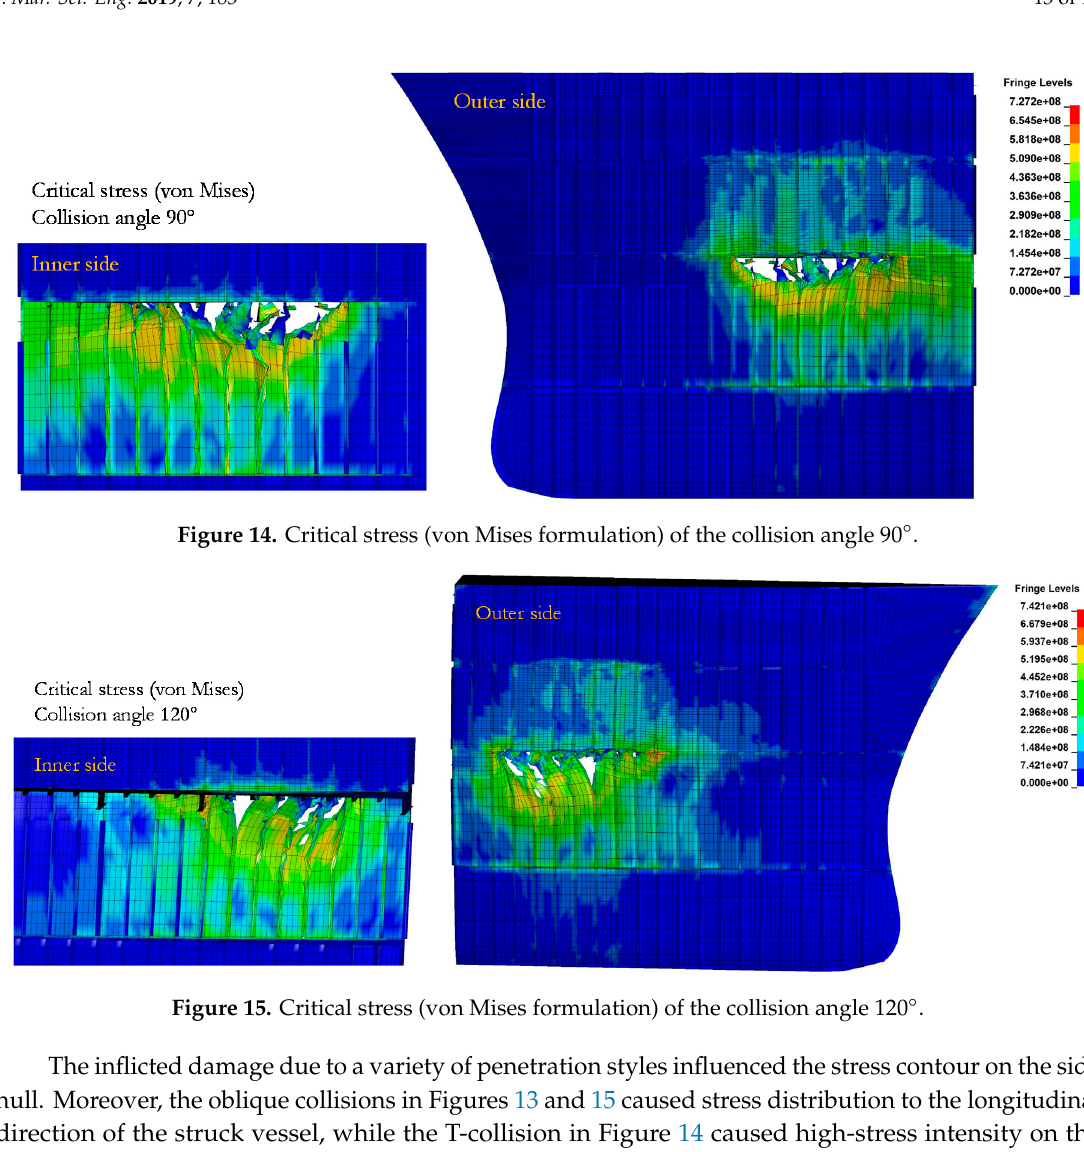
Figure 13. Critical stress (von Mises formulation) of the collision Angle 60°.